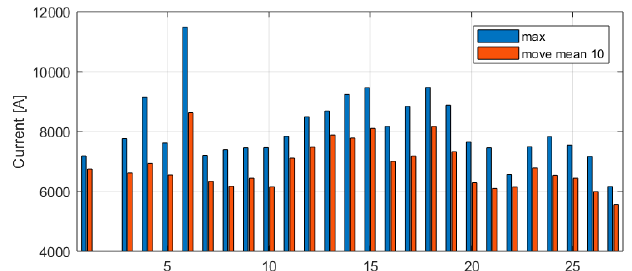
Figure 13. Current of substations.